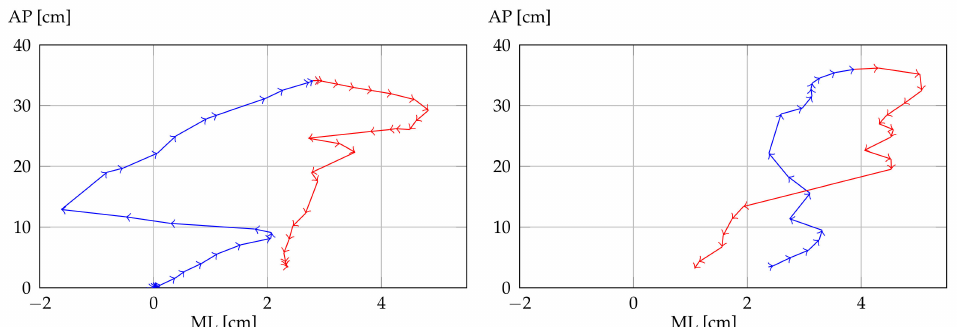
Figure 8. Representations of anteroposterior (AP) and mediolateral (ML) movements of center of mass in two consecutive ascending and descending phases. Blue lines, ascending phases; red lines, descending